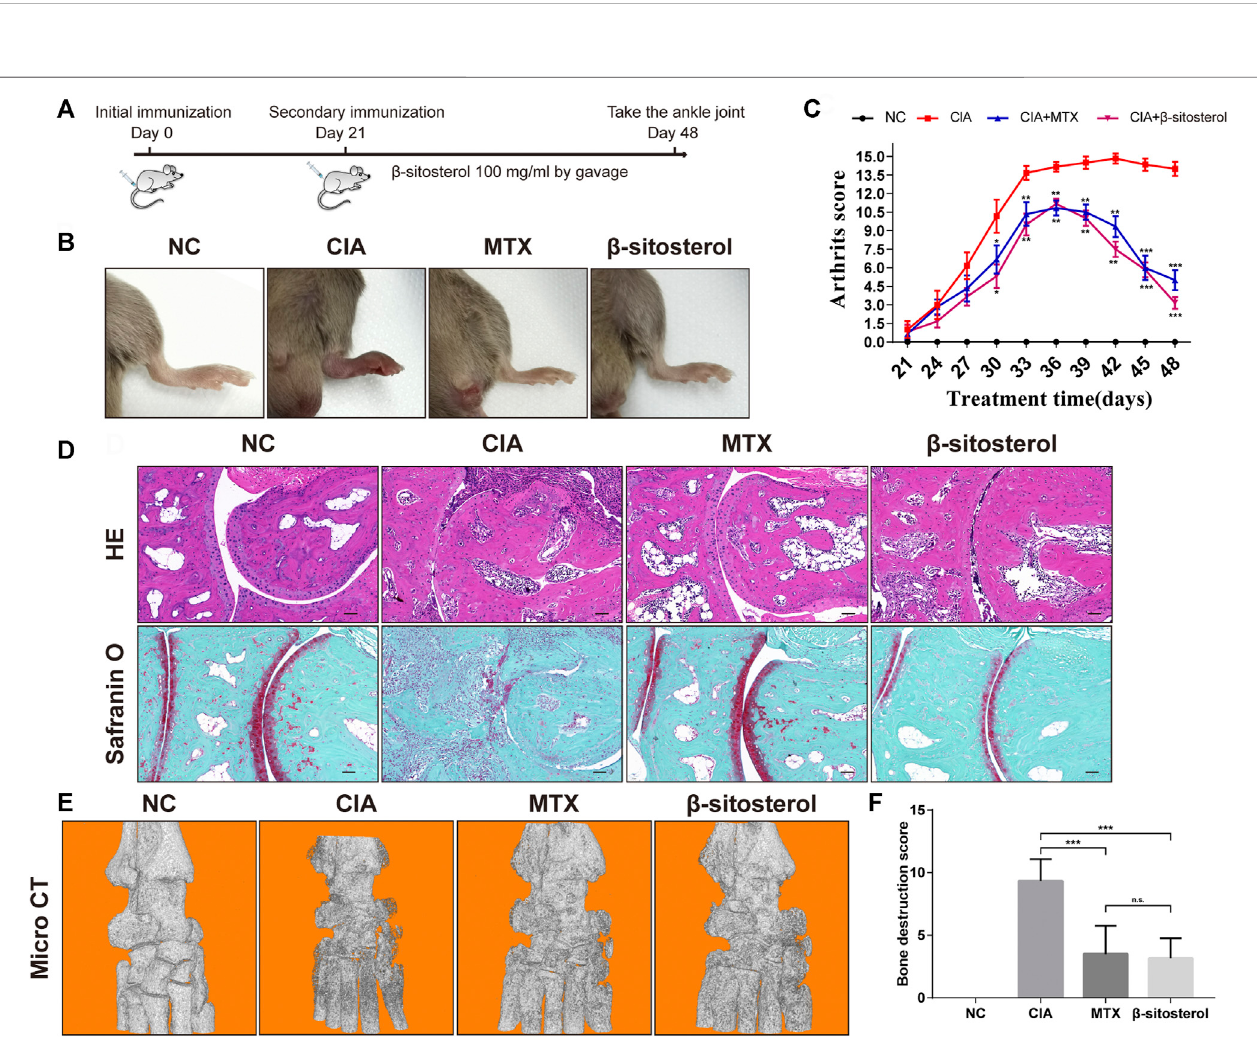
FIGURE 5 | Effects of BSS on experimental arthritis. (A) Animal experiment process, (B) the mice foot swelling photos, (C) Arthritis scores were shown. (D) Ankle HEandsafraninO-fastgreenstaininginthemicefromeachgroup( n =6). (E) Micro-CTdetectionofbonedestructionintheanklejointofeachgroupofmice,andanalysis of (F) bone destruction scores in each group ( n = 6). * p < 0.05, ** p < 0.01, *** p < 0.001, n.s. = not signi fi cant.